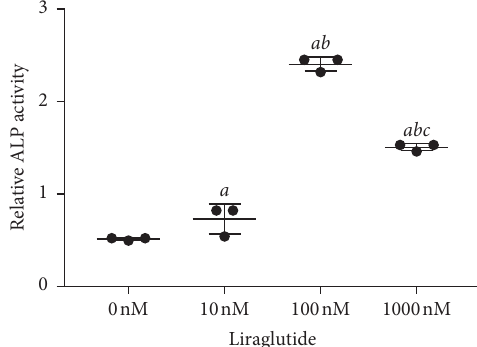
Figure 2: The effect of liraglutide on alkaline phosphatase (ALP) activity in MC3T3-E1 cells. The cells were treated with liraglutide at different concentrations. aP < 0.01 compared with 0nM, bP < 0.01 compared with 10nM, and cP < 0.01 compared with